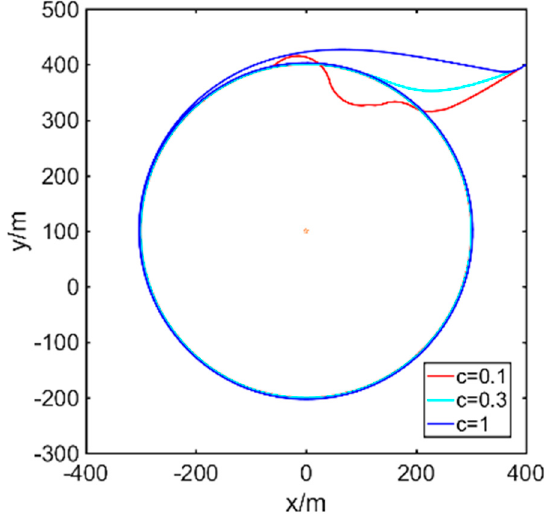
Figure 6. Trajectories with different guidance parameter c .